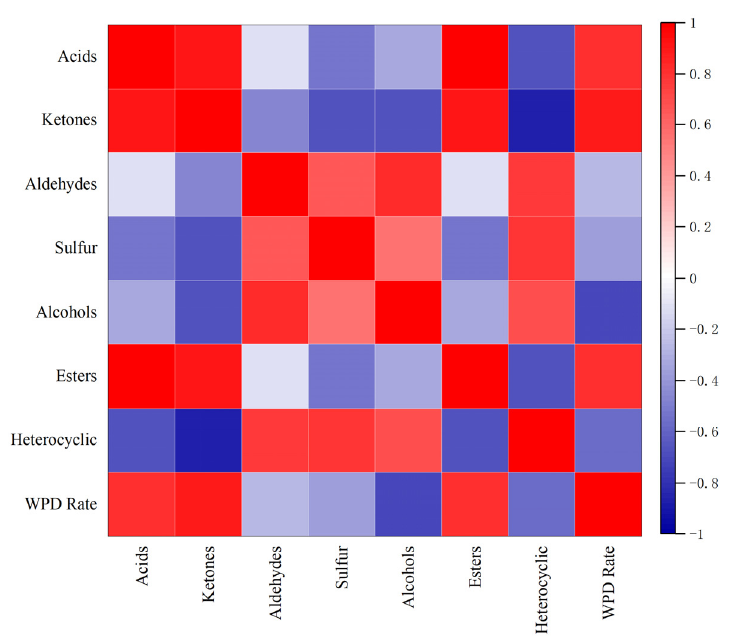
Figure 7. Correlation between WPD and seven flavor substances extracted by different methods (WPD Rate = Whey protein denaturation rate). (WPD Rate = Whey protein denaturation